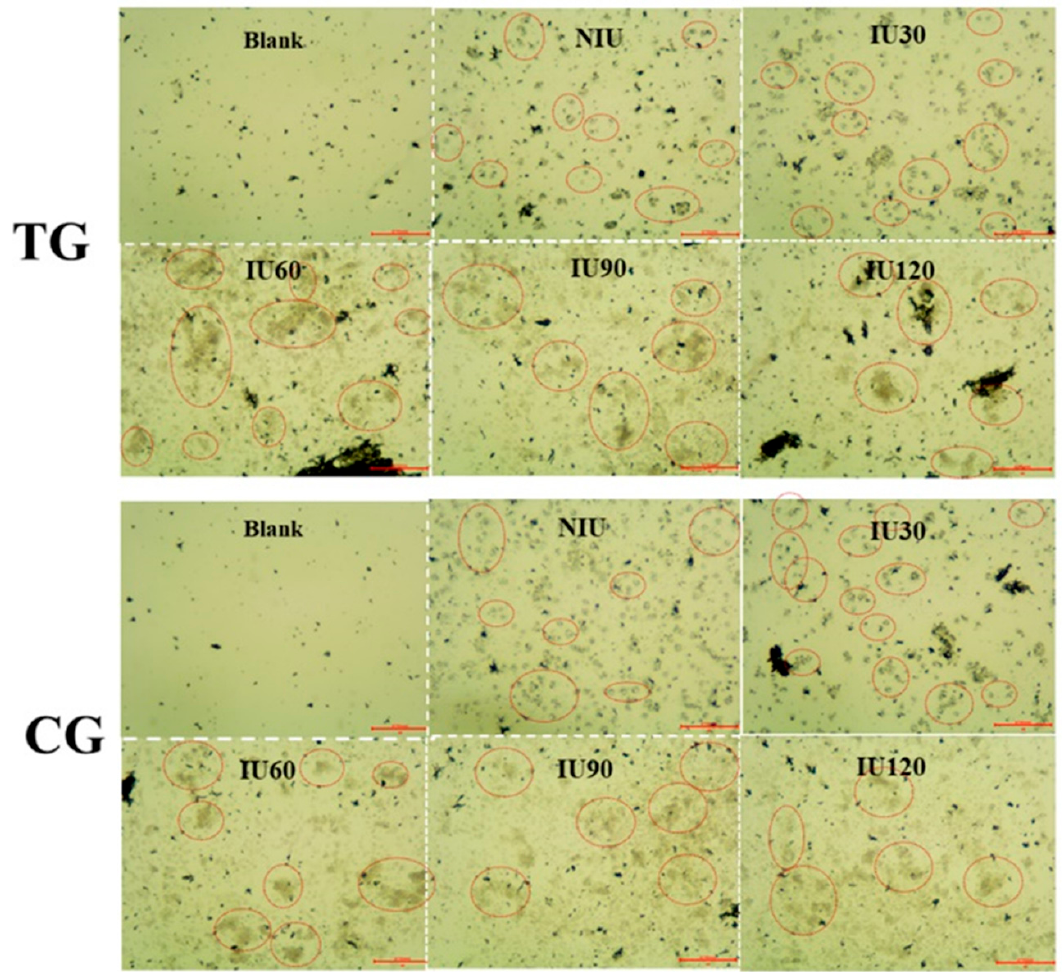
Figure 2. Micrographs of captured cells (MDAMB231 as an example) on the surface of AS1411 and PGO functionalized slides. The photos are classified in two groups, corresponding to the test group (TG) and the control group (CG). Each of them contains two rows, in which the top-right photos are the slides without cells, being used as references to identify the anchored cells in the last five images; meanwhile, the other 5 photos are distinguished from the fixed cells which are without the iodide-uptake treatment (NIU), and treated by IU with various durations 30, 60, 90 and 120 min, labeled as IU30, IU60, IU90 and IU120, respectively.